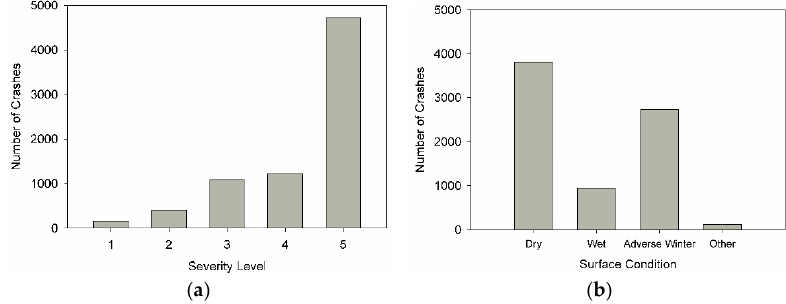
Figure 3. The histogram of ( a ) the severity levels for the roadway departure crashes and ( b ) the weather-related surface condition during the crash events.